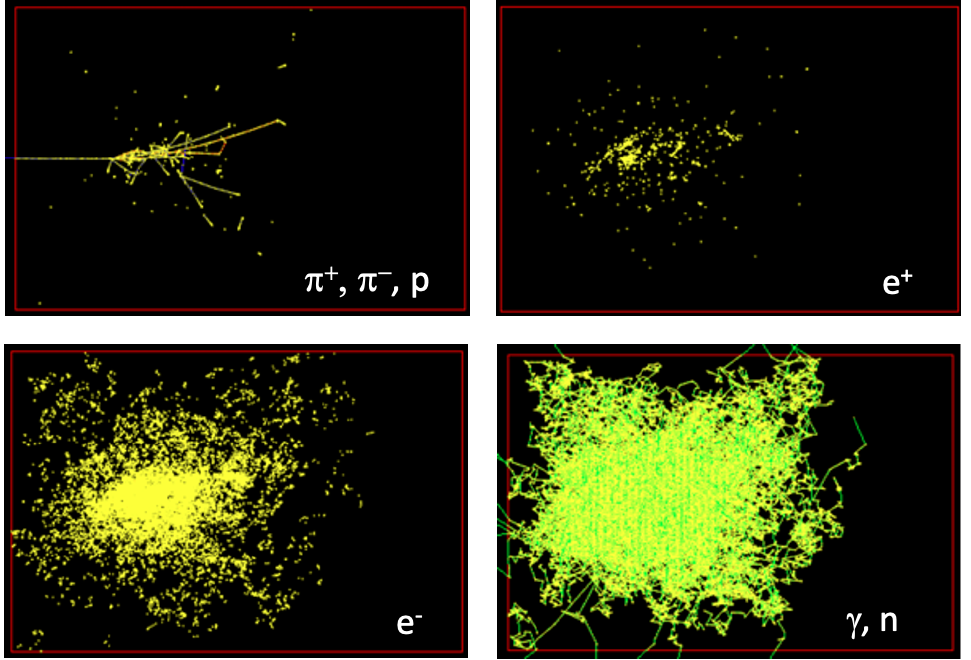
Figure 2. Images of shower particles for a single 30 GeV π + in a solid copper absorber (100 × 100 × 150 cm 3 ): Slow neutrons and γ s from neutron capture by nuclei spread widely and form a fuzzy image ( bottom right ), while fast π + , π − , and protons display a clear view of hadronic vertices and tracks ( top left ). The e + ( top right ) and e − ( bottom left ) are shown separately. The e + s arise mainly from the fast component of the shower in e + e − pairs by gammas from π 0 → γγ decays, whereas the e − s also arise from the slow component due to the Compton scattering of widely spread γ s in addition to counterparts of positions in the fast